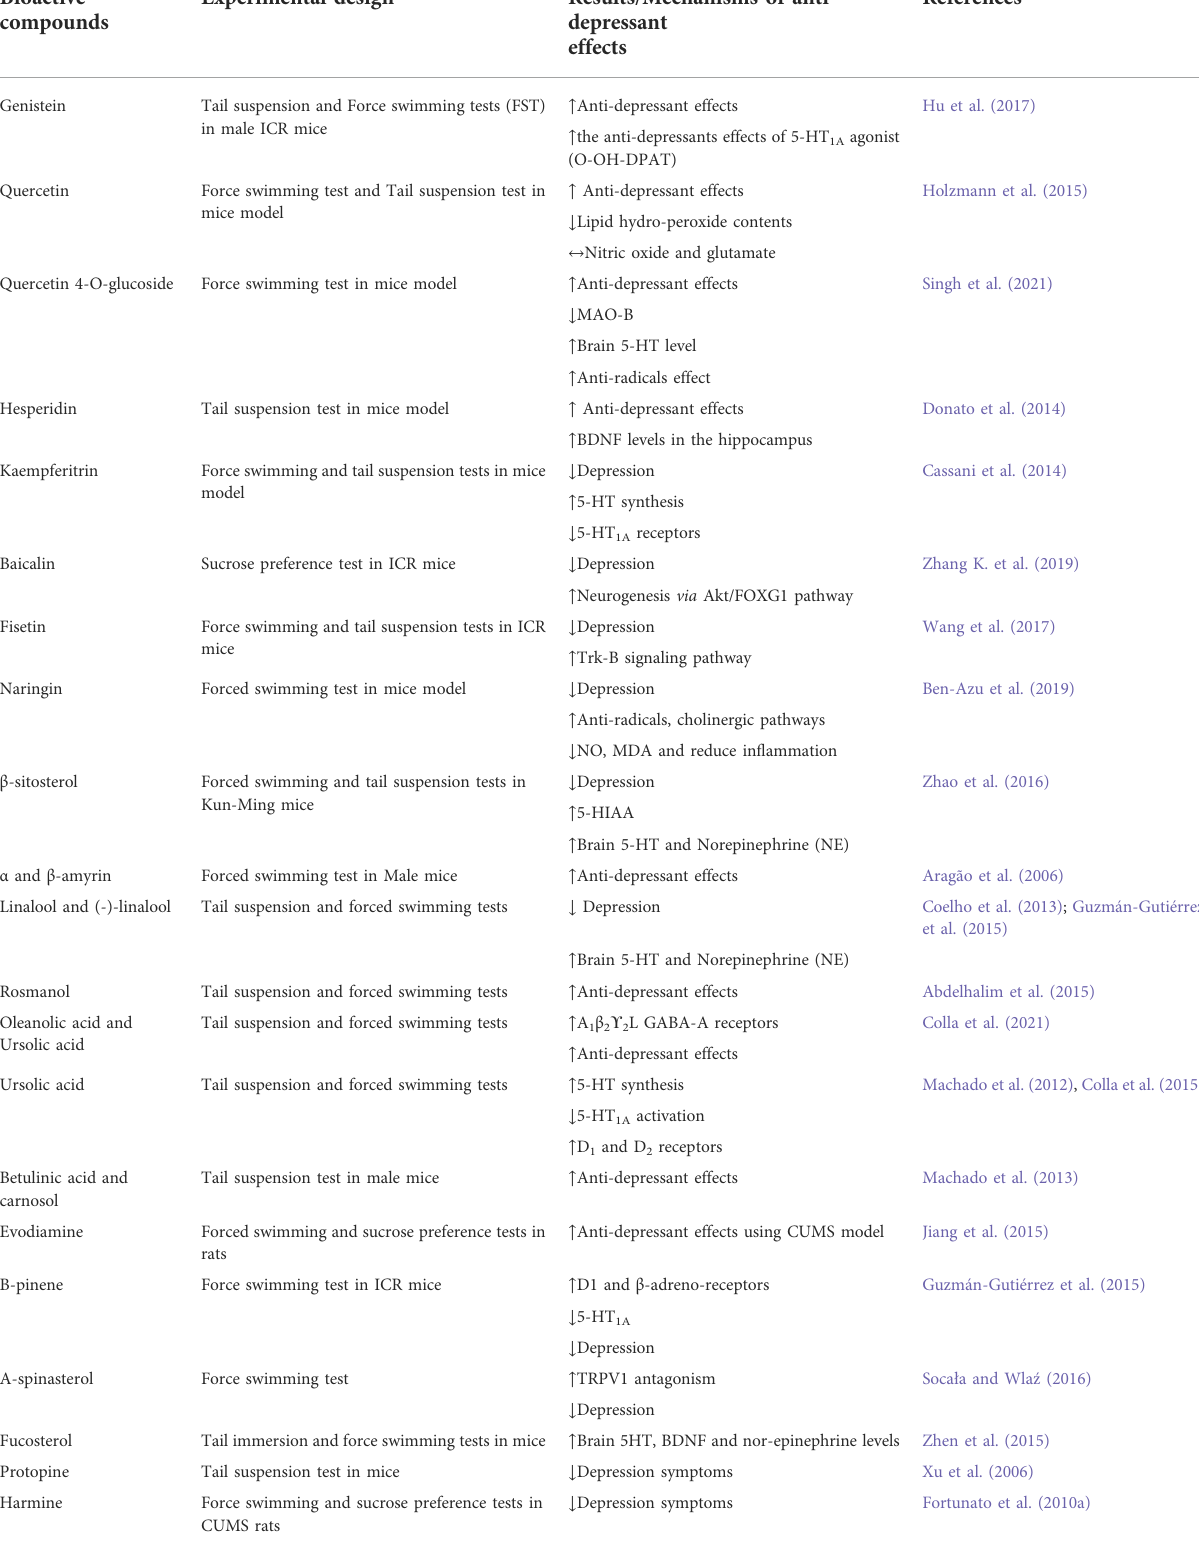
TABLE 1 Details of Phytochemicals, their sources and anti-depressant